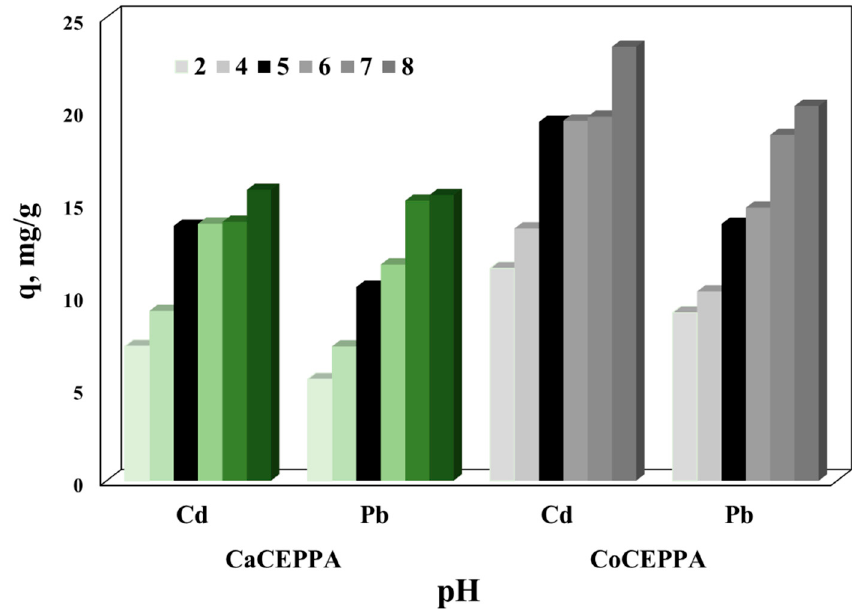
Figure 4. The influence of pH on the adsorption capacity of CaCEPPA and CoCEPPA in the removal process of cadmium and lead from aqueous solutions.